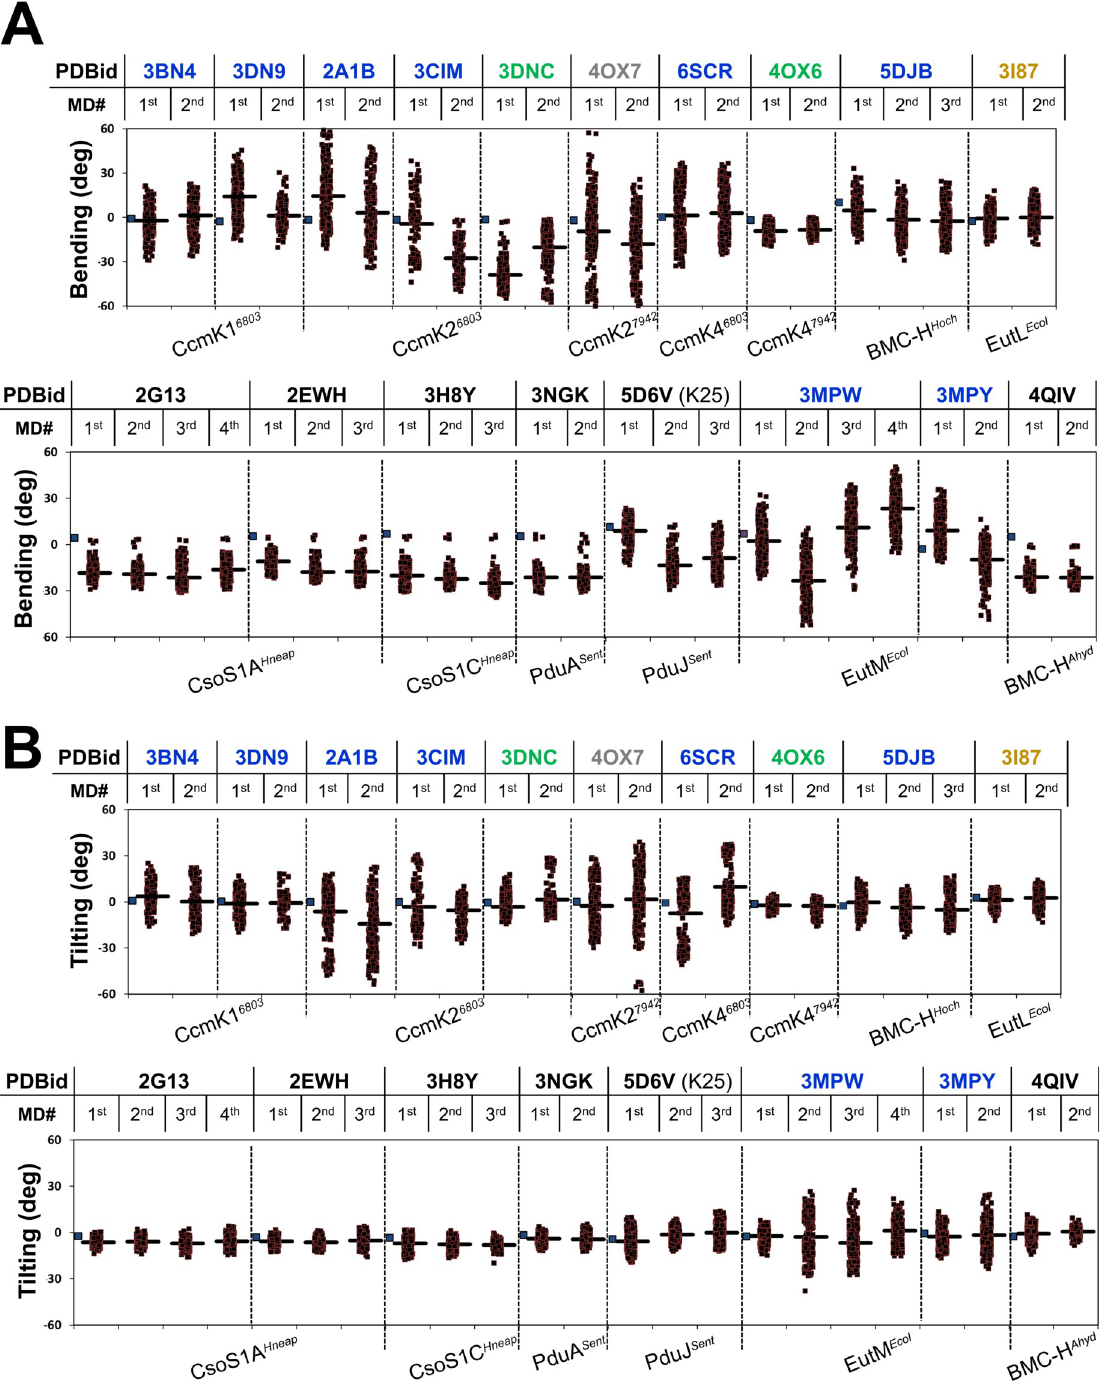
Fig 3. BMC-H tri-hexamer behavior during MD simulations. Plot of bending (panel A ) and tilting ( B ) angles calculated through all-atom MD trajectories of ensembles of three BMC-H originally positioned as in crystal structures (indicated by PDB entry codes on top). Bending angles were calculated taking the C α atom positions of S27 and Ile38 from one of the interfacial monomers of a given hexamer (PduA Sent , corresponding residues in other BMC-H) with regard to same residues on the symmetric monomer of the interacting hexamer counterpart. That was applied on all 3 hex-hex interfaces. Similarly, tilting values are based on C α positions of M24 and Ile18 from two monomers of a given hexamer with regard to the same residues on the symmetric monomers of the contacting hexamer. Each point corresponds to one of three measurements for a given snapshot (0.25 ns, black squares). Data from up to 4 independent 20 ns simulations are presented separately (1 st to 4 th ). Thick traces represent the mean value calculated over the entire MD run. Blue squares on the most left side for each PDB